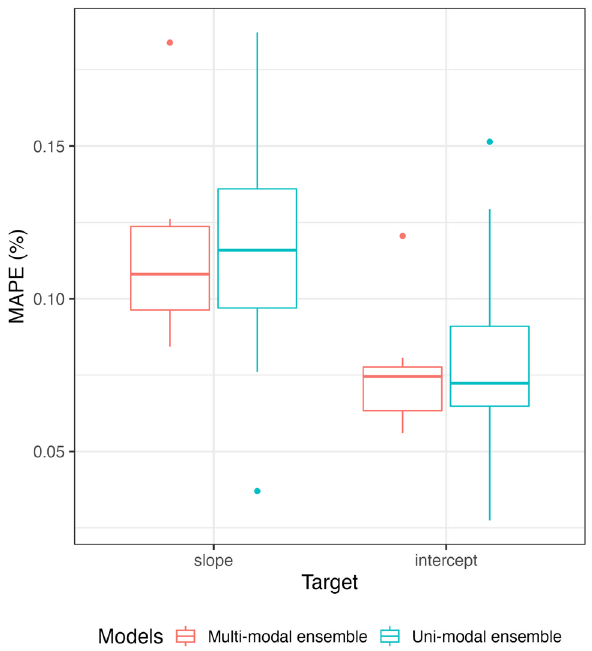
Figure 4. Distributions of MAPE regarding multi-modal and uni-modal ensemble forecasting models.